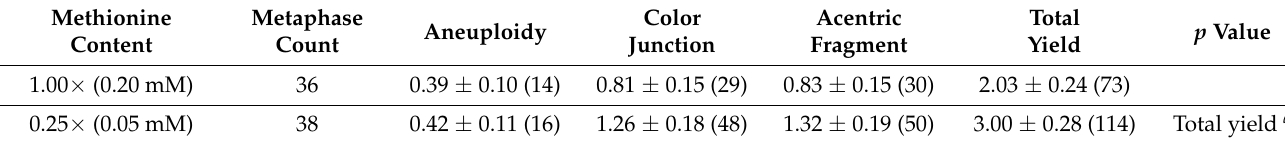
Table 2. Distribution of aberration frequencies ± standard errors (number of aberrations observed) detected by Spectral Karyotyping (SKY) analysis after 1-month culture of RAW 264.7 cells in either methionine-adequate or methionine-deficient media followed by a single exposure of 2 Gy. Cells were harvested 24 h after radiation. a, statistically significant difference in total yield from 1.00 × media.